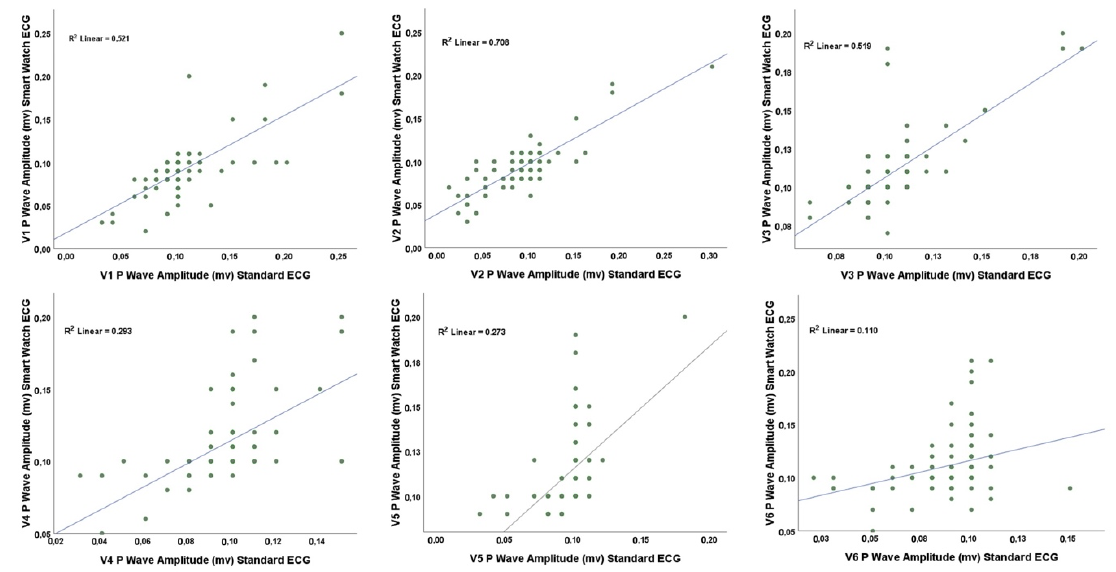
Figure 3. Correlation between P wave amplitude in precordial leads between standard- and SW-ECG.